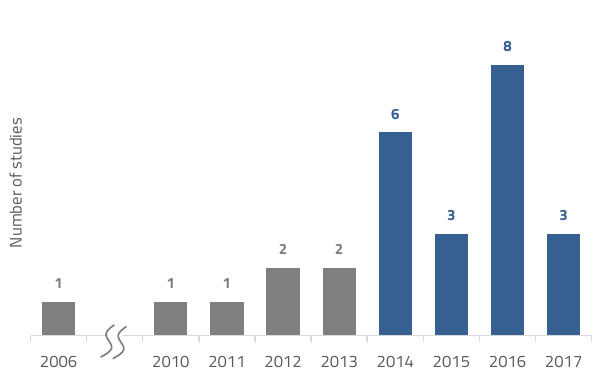
Figure 4. Number of studies analysed per year.